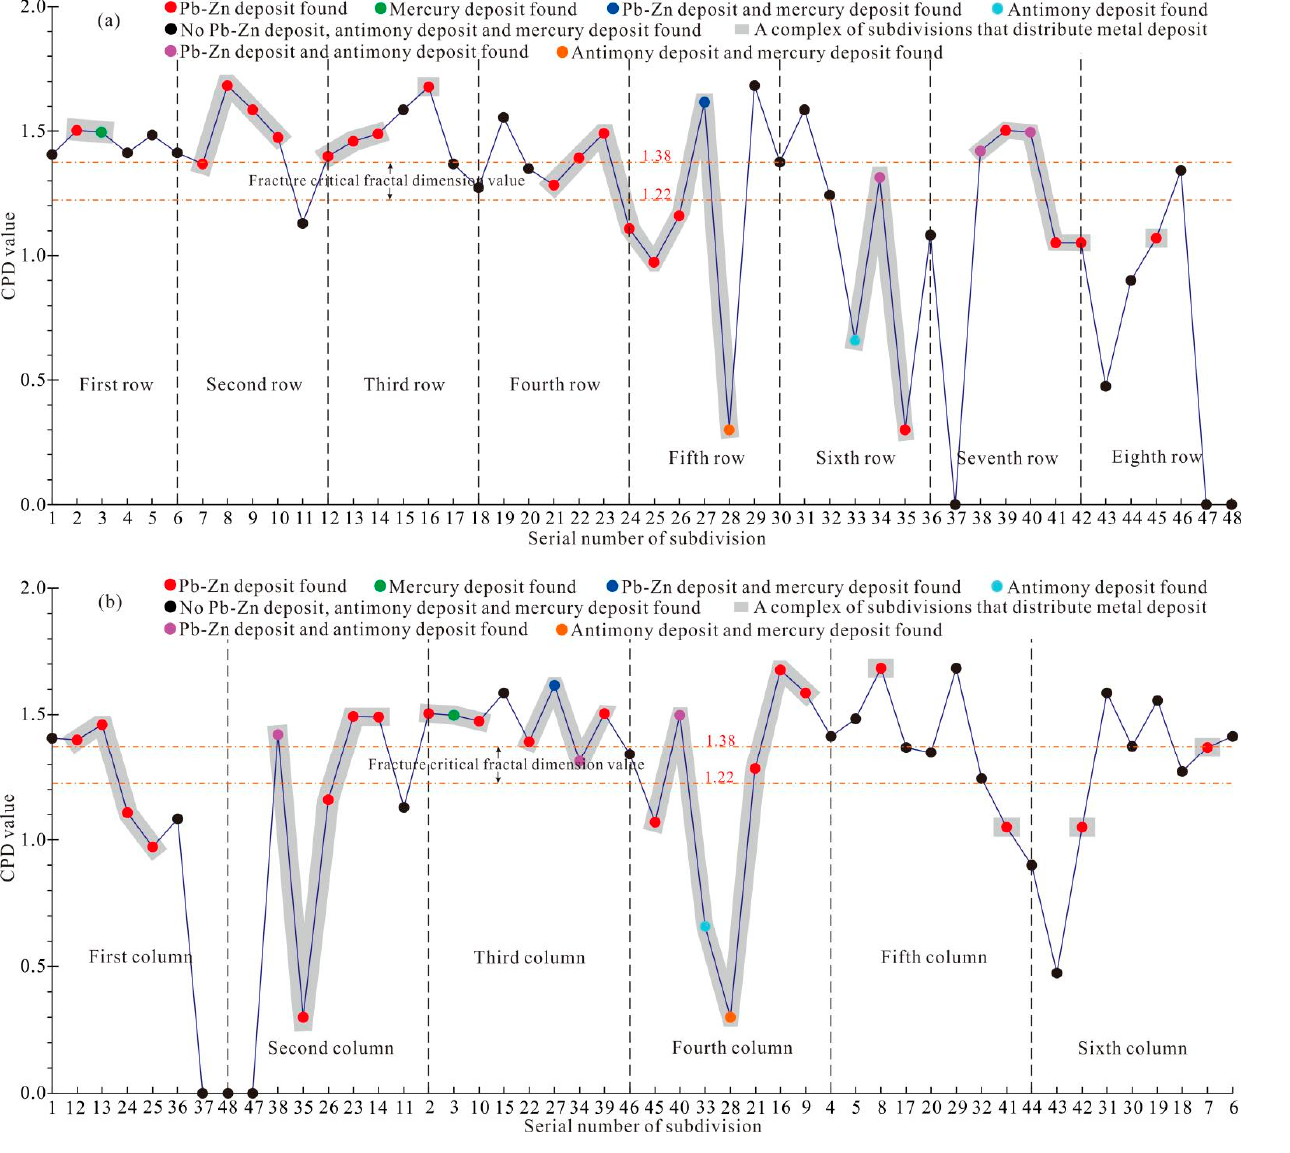
Figure 9. Vertical and horizontal wave graphs of fractal dimensions. ( a ) Horizontal wave graphs of fractal dimensions; and ( b ) Vertical wave graphs of fractal dimensions.